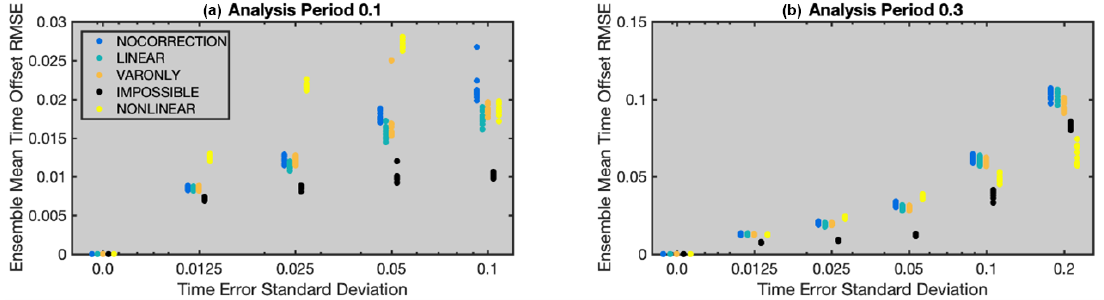
Figure 3. The RMSE of the estimate of the time offset for cases with an analysis period of (a) 0.1 time units and (b) 0.3 time units. A total of 10 experiments were run for each of the five methods, with each method indicated by a different color. The horizontal axis is logarithmic except for the 0